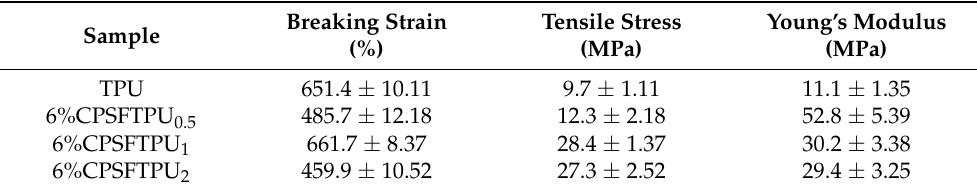
Figure 8. ( a ) Tensile curves and ( b ) mechanical properties of semi IPNs 6%CPSFTPU x series with different ratio of P(St- co -FMA)/TPU. Table 2. Mechanical properties of semi IPNs 6%CPSFTPU x series with different ratio of P(St- co - FMA)/TPU.